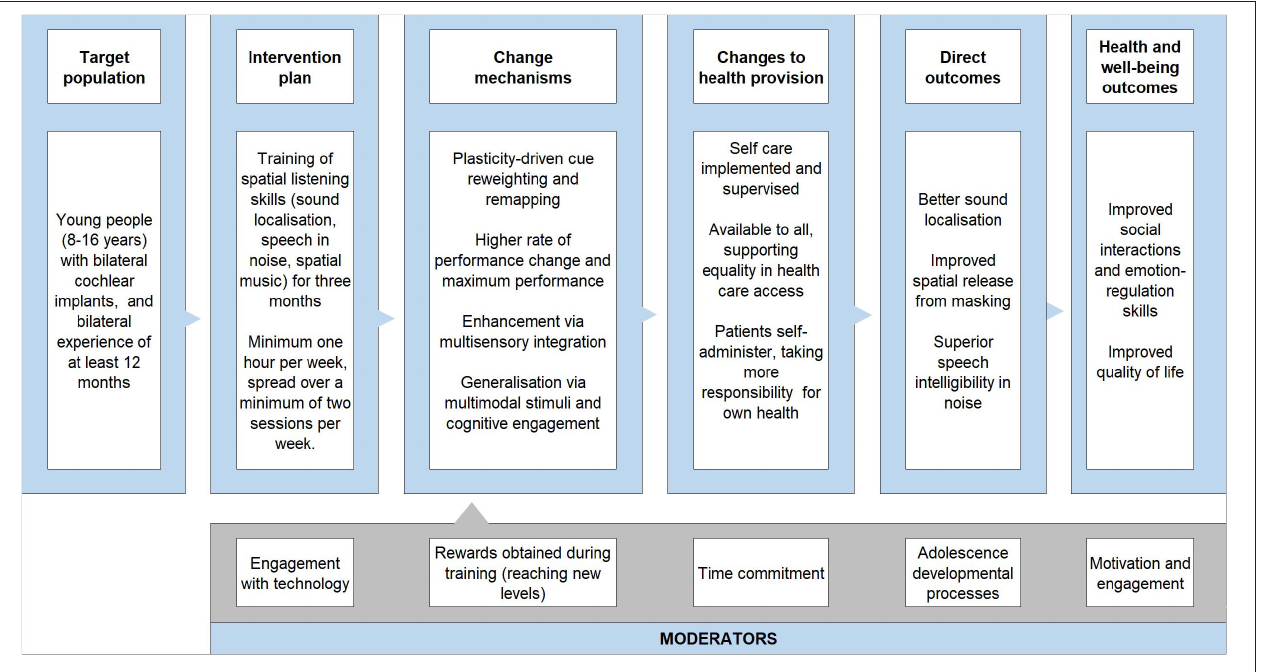
FIGURE 2 | The logic model to explain the BEARS training suite